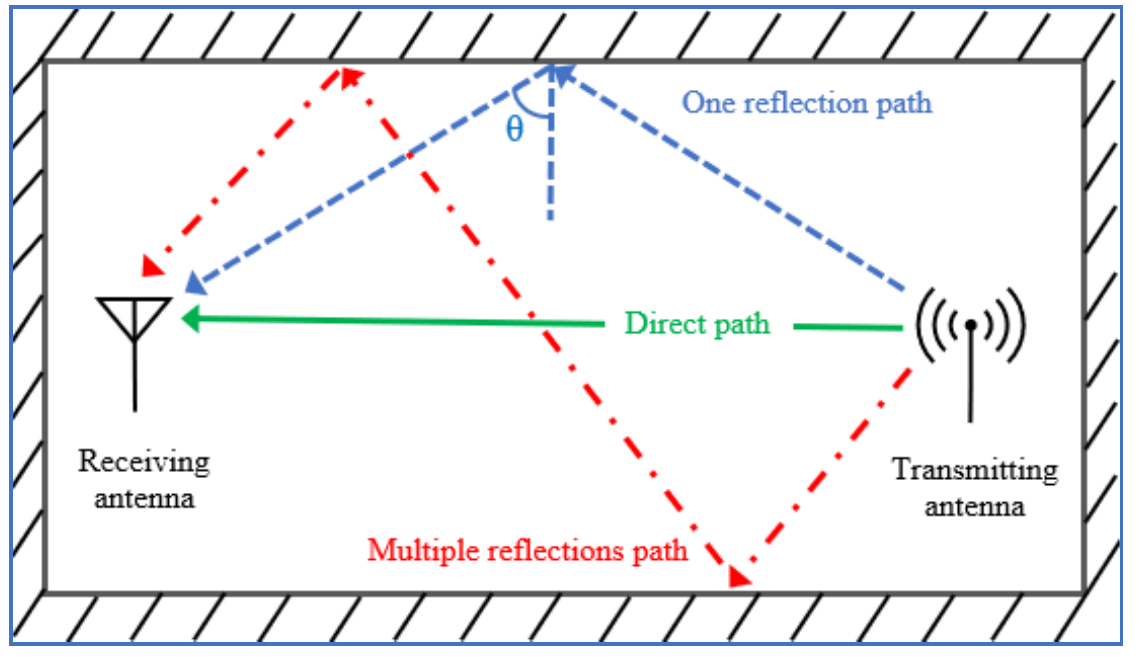
Figure 2. An indoor multipath propagation scenario.